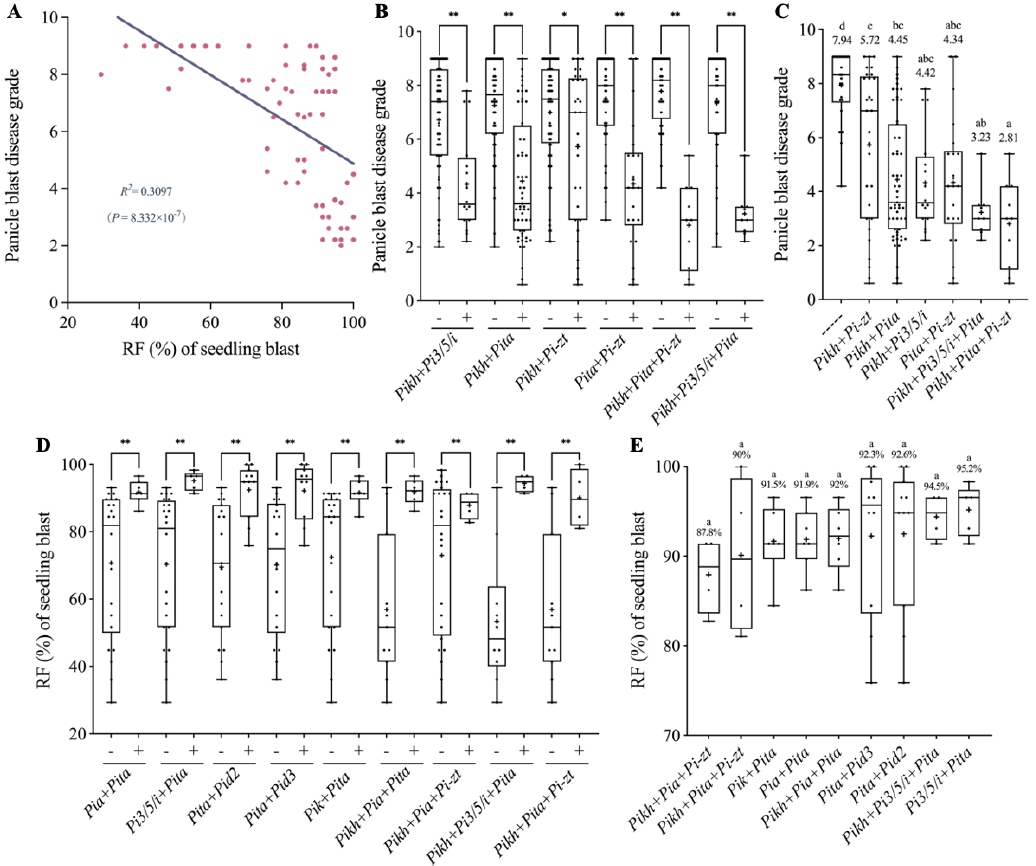
Figure 4. Correlation analysis between seedling blast resistance and panicle blast resistance. ( A ) Regression analysis of seedling blast RF and panicle blast disease grade. ( B ) Comparison of the panicle blast disease grades in 5 MCSs between elite R -gene combinations and corresponding controls from seedling blast resistance tests. “ - ” and “+” denote the varieties with or without corresponding gene combinations. **: p < 0.01 and *: p < 0.05 by Student’s two -sided t-test. ( C ) Comparison of panicle blast disease grades between different elite R -gene combinations from ( B ). The numbers indicate average disease grades. Different lowercase letters indicate significant differences according to Duncan’s multiple range tests ( p < 0.05). ( D ) Comparison of the seedling blast RFs between elite R -gene combinations and corresponding controls from panicle blast resistance tests. “ - ” and “+” denote the varieties with or without corresponding gene combinations. **: p < 0.01 by Student’s two -sided t -test. ( E ) Comparison of the seedling blast RFs between different elite gene combinations from ( D ). The numbers indicate average RFs.